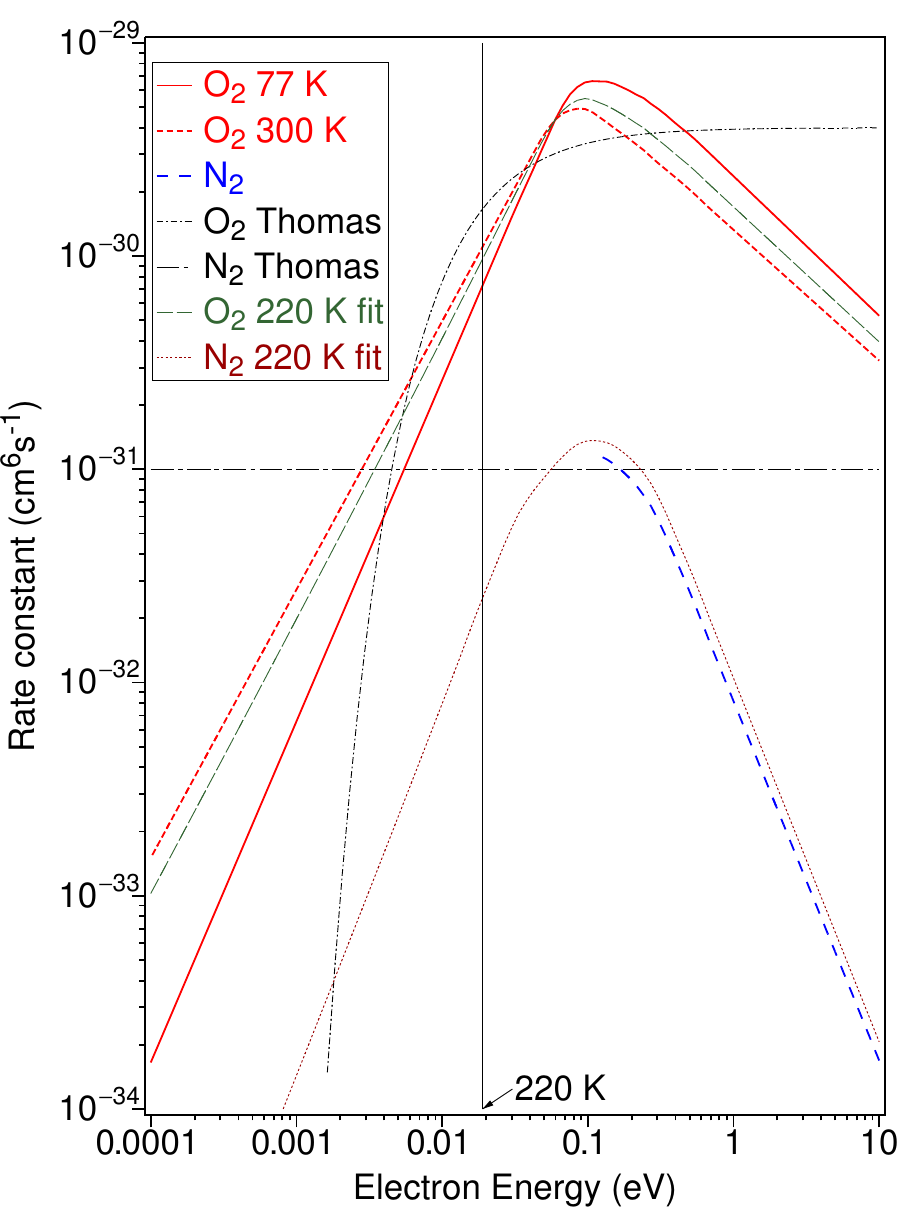
Figure 5. Rate constants (cm 6 s − 1 ) as a function of electron energy (eV) for attachment Reaction (R12) (labelled with “O 2 ”) measured [20] at 77 K (—–) and 300 K (––––), calculated for 220 K (— —) and as given [13] for a Maxwelllian distribution (—-—-—). Similarly, for (R13) (labelled with “N 2 ”) measured [20] at 300 K (— — —), calculated for 220 K (---) and for a Maxwellian distribution [13] (—— –